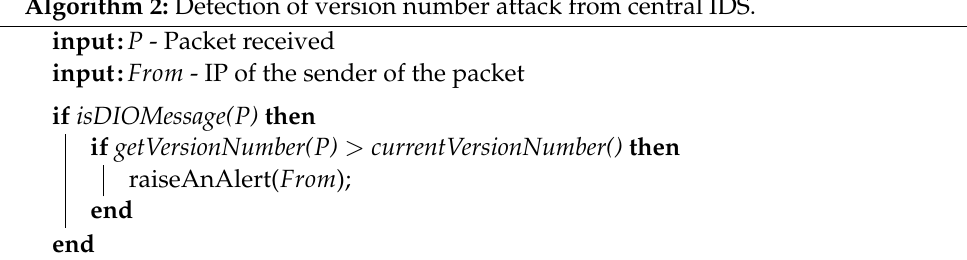
Algorithm 2: Detection of version number attack from central